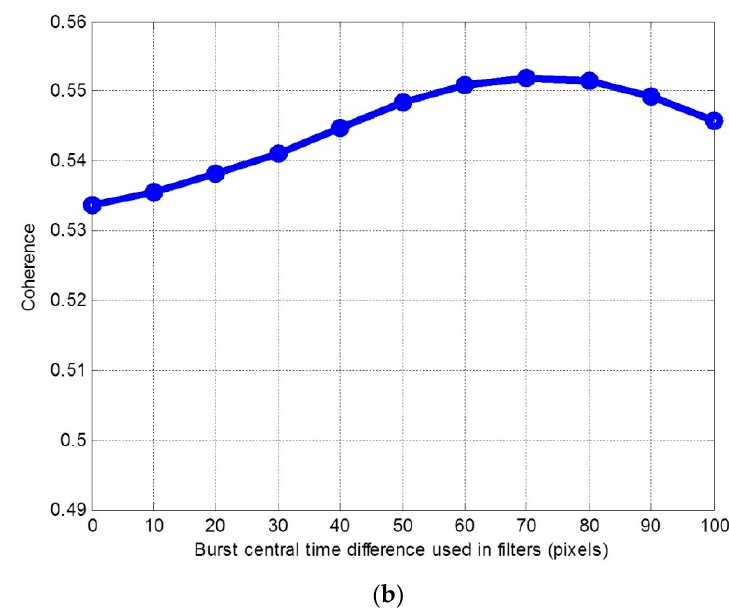
Figure 5. | ∆ T | versus coherence processed from the two images shown in Figure 4. ( a ) Results when using rectangular filters; ( b ) results when using combined filters.